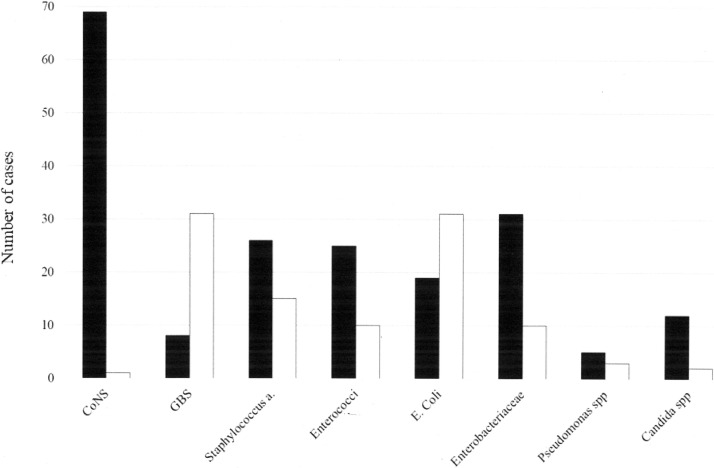
Prominent pathogens in hospital- or community-acquired late-onset sepsis cases.CoNS, coagulase-negative staphylococci; GBS, group B streptococcus. One neonate had both community and hospital acquired LOS. Full bars, hospital-acquired LOS. Empty bars, community-acquired LOS. Pathogens causing LOS include: CoNS: Staphylococcus epidermidis (n = 52), S. warneri (n = 7), S. haemolyticus (n = 2), S. capitis (n = 5), S. hominis (n = 1), S. caprae (n = 1), polymicrobial CoNS (n = 3). Enterococci: E. faecalis (n = 25), E. faecium (n = 11), E. avium (n = 1), Enterobacteriaceae: Klebsiella pneumoniae (n = 18), Klebsiella oxytoca (n = 5), Enterobacter aerogenes (n = 3), Enterobacter cloacae (n = 10), Serratia marcescens (n = 3), Pantoea spp (n = 1), Proteus mirabilis (n = 1) Pseudomonas spp: Pseudomonas aeruginosa (n = 7), Putida (n = 1), Oryzihabitans (n = 1), Candida spp: Candida albicans (n = 8), C. tropicalis (n = 1), C. lusitaniae (n = 1), C. famata (n = 1), C. Glabrata (n = 1), C. parapsilosis (n = 2).